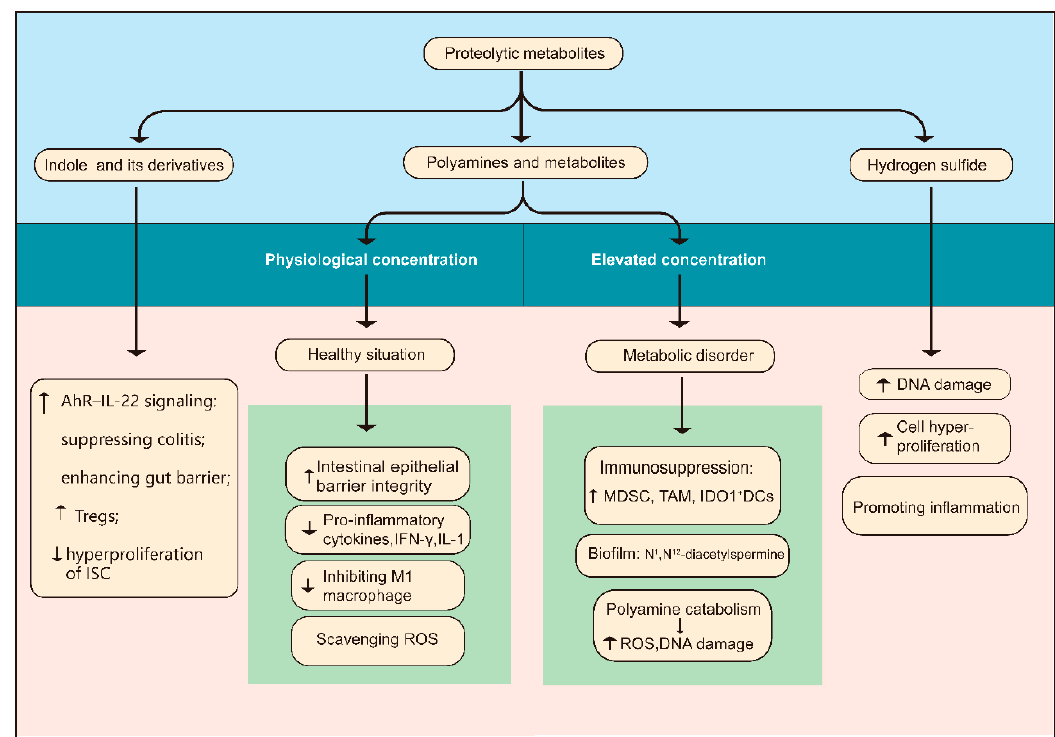
Figure 2. Immunomodulatory metabolites from dietary protein. There are some representative protein-derived metabolites related to immunoregulatory functions, comprising indole and its derivates, polyamines, and hydrogen sulfide. AhR, aryl hydrocarbon receptor; ISC, intestinal stem cell; ROS, reactive oxygen species; RNS, reactive nitrogen species; MDSC, myeloid-derived suppressor cells; TAM, tumor-associated macrophages; IDO1, indoleamine 2,3-dioxygenase 1.